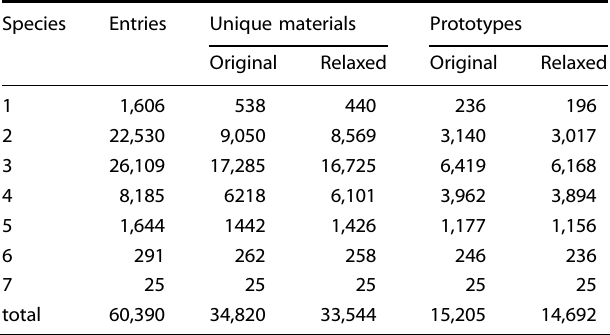
Table 3. Number of unique materials and prototypes in the AFLOW- ICSD repository. The statistics are organized by number of species, and the counts are shown for the original and DFT-relaxed entries. Species